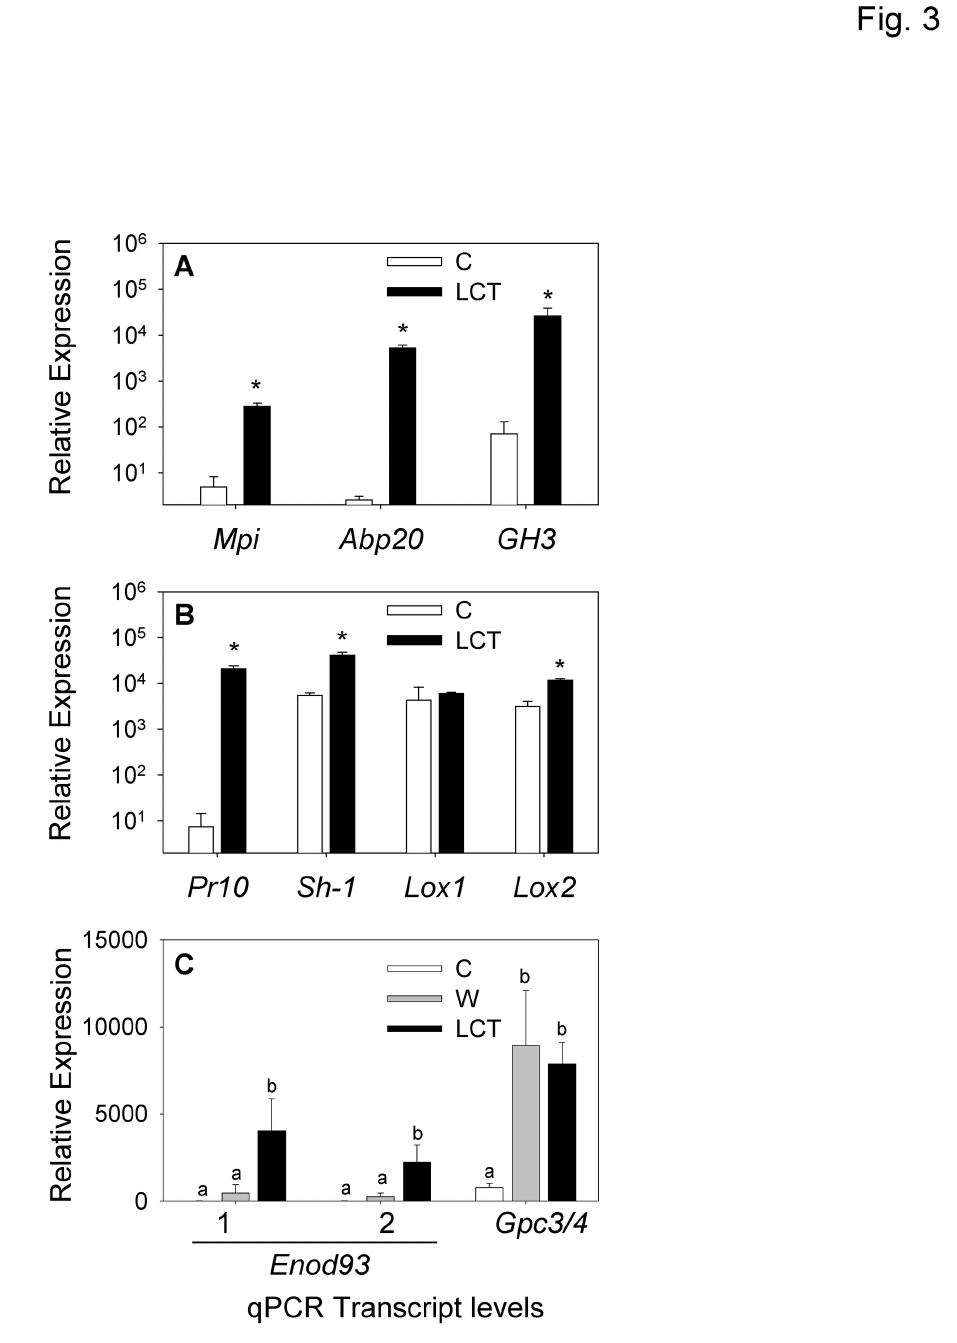
Figure 3. Validation of ECB-induced microarray probe sets with qRT-PCR. A , Average ( n = 3, +SEM) relative gene transcript expression levels for Mpi , Abp20 , and GH3 which encode the Maize protease inhibitor, Auxin binding protein-20, and a predicted indole-3-acetic acid-amido synthetase. Undamaged control stem tissues (C, white bars) and 48 h larval-conditioned tissue (LCT, black bars). B , Similarly, average ( n = 3, +SEM) relative gene transcript expression levels for Pr10 , Sh-1 , Lox1 , and Lox2 which encode the proteins Pathogenesis-related 10, Sucrose synthase-1, Lipoxygenase 1 and Lipoxygenase 2. Significant differences indicated by asterisk (Student’s t -test, P < 0.05). C , Average ( n = 3, +SEM) relative gene transcript expression levels for Enod93-1 , Enod93-2 , and Gpc3/4 encoding two early nodulin 93 proteins and cytosolic glyceraldehyde-3-phosphate dehydrogenase 3/4, respectively for control (white bars), wound (grey bars), and larval-conditioned tissue (LCT, black bars). Different letters (a–b) represent significant differences (all ANOVAs P < 0.01; Tukey test corrections for multiple comparisons, P < 0.05). doi: 10.1371/journal.pone.0073394.g003 PLOS ONE |